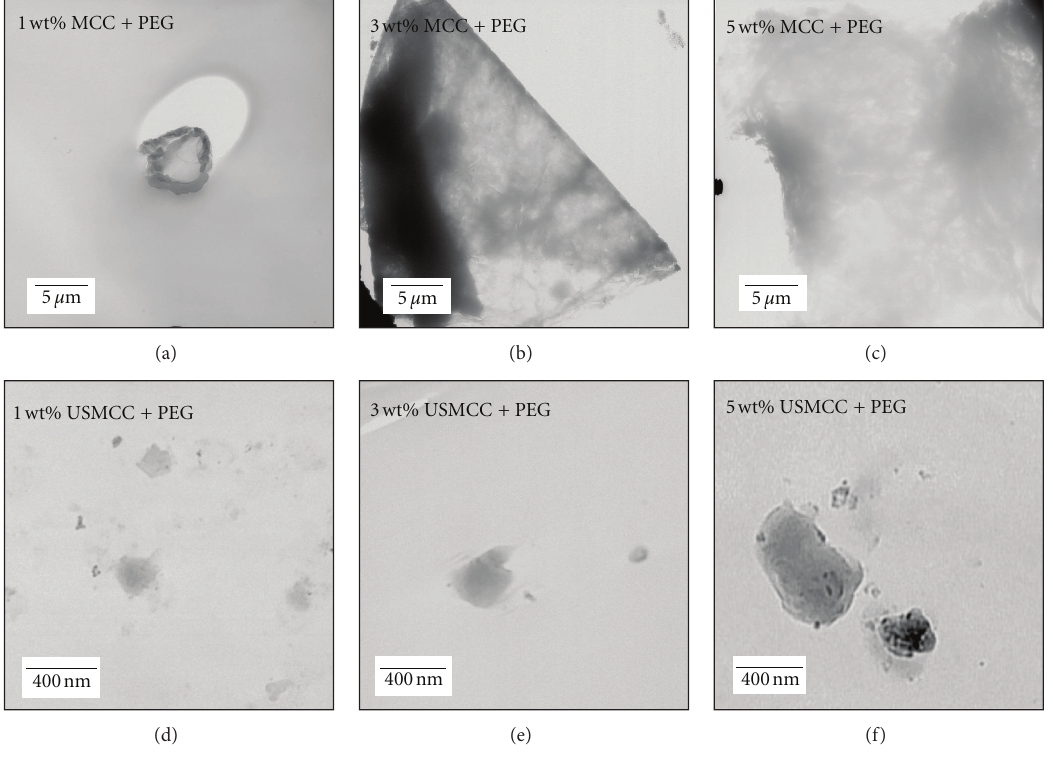
F 8: �EM images of the modi�ed